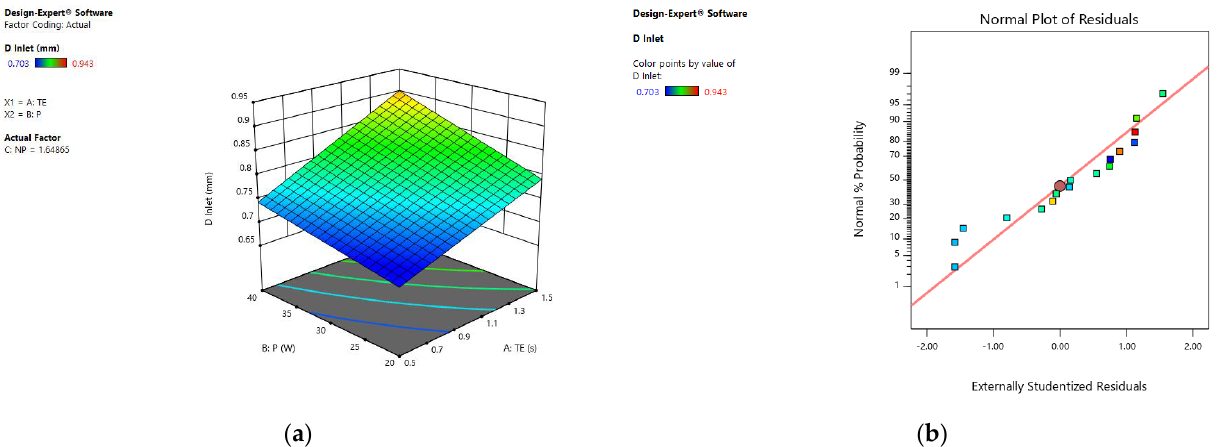
Figure 17. ANOVA model results for D INLET at 0.05 wt.% CNPs: ( a ) 3D response surface and ( b ) normal residuals plot.